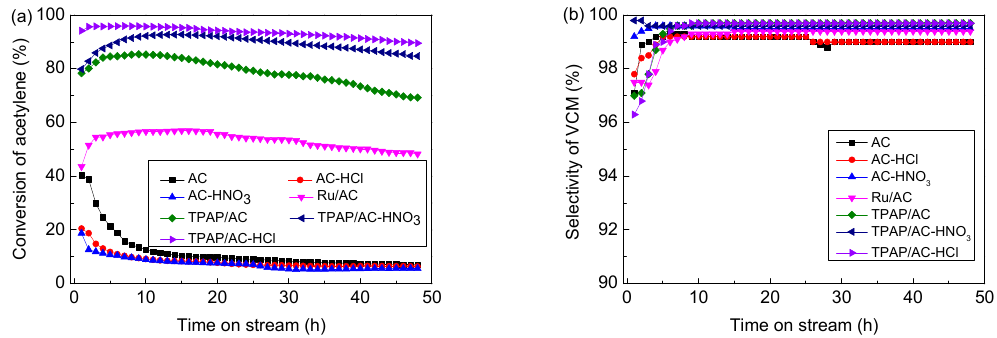
Figure 1. Acetylene conversion ( a ) and selectivity to vinyl chloride monomer (VCM) ( b ) over the prepared catalysts. Reaction conditions: temperature ( T ) = 180 °C, GHSV(C 2 H 2 ) = 180 h − 1 , and V HCl / V C2H2 = 1.15.